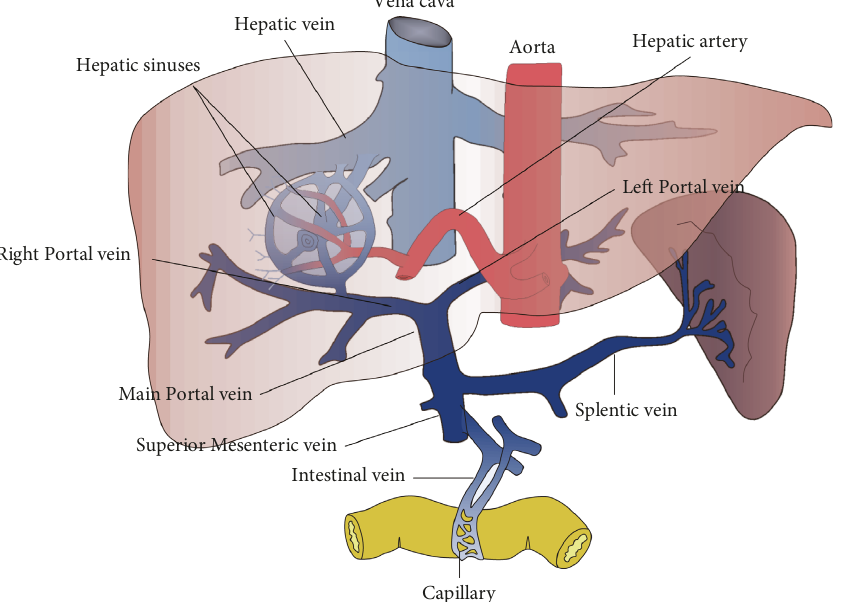
Figure 1: Anatomic structure of PV system.